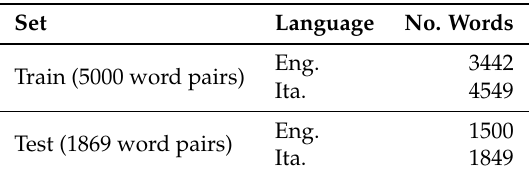
Table 1. Statistics of word